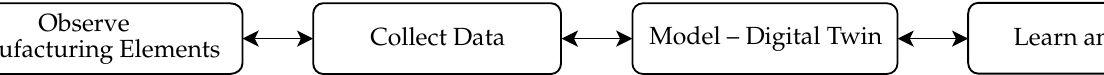
Figure 1. Principle of creating a digital twin according to ISO 23247.